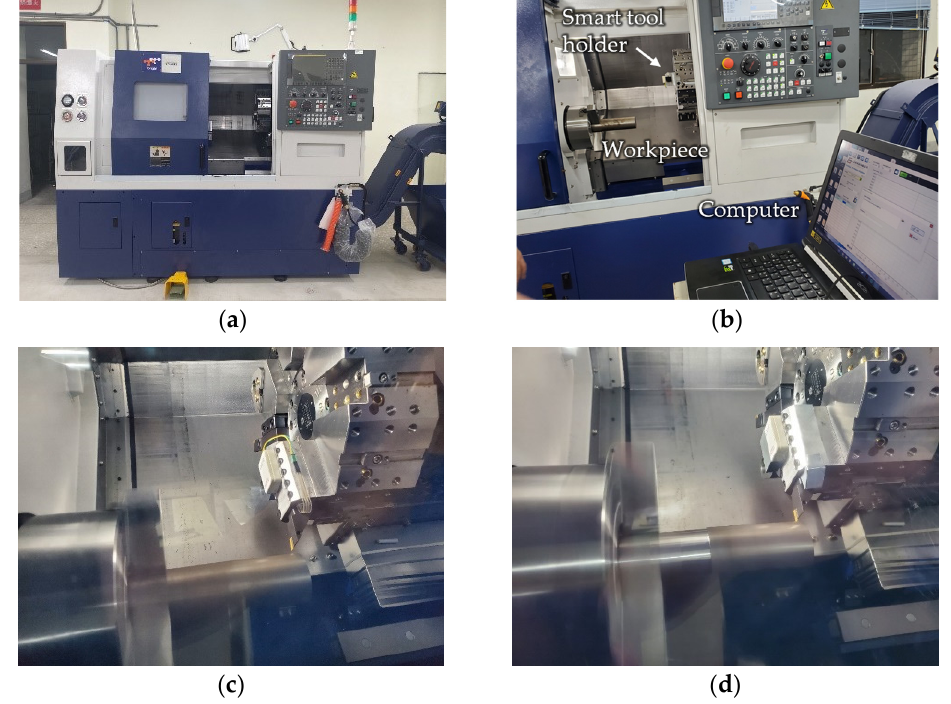
Figure 15. The turning experiment setup: ( a ) Tongtai TS-85 bedroom CNC lathe; ( b ) the workpiece, smart tool holder, and the turning tool installed on the machine tool, and a personal computer next the machine tool; ( c ) the bare smart tool holder; and ( d ) the smart tool holder with aluminum protective shielding.